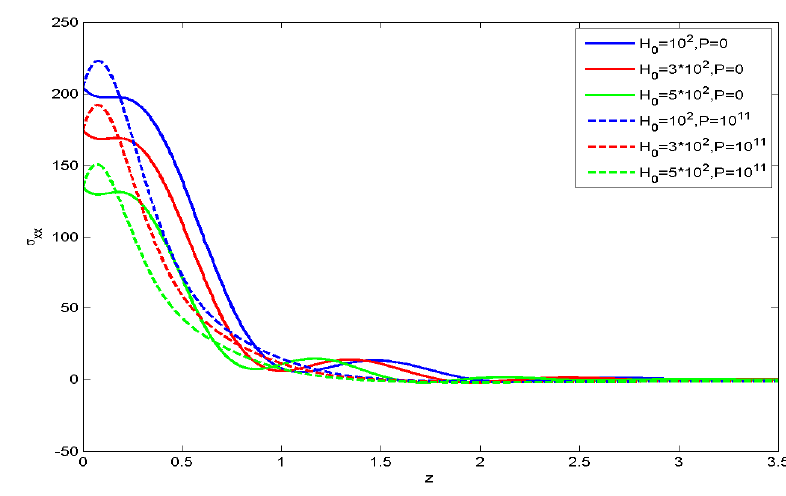
Figure 19. Vertical displacement distribution w concerning z with magnetic field H 0 .